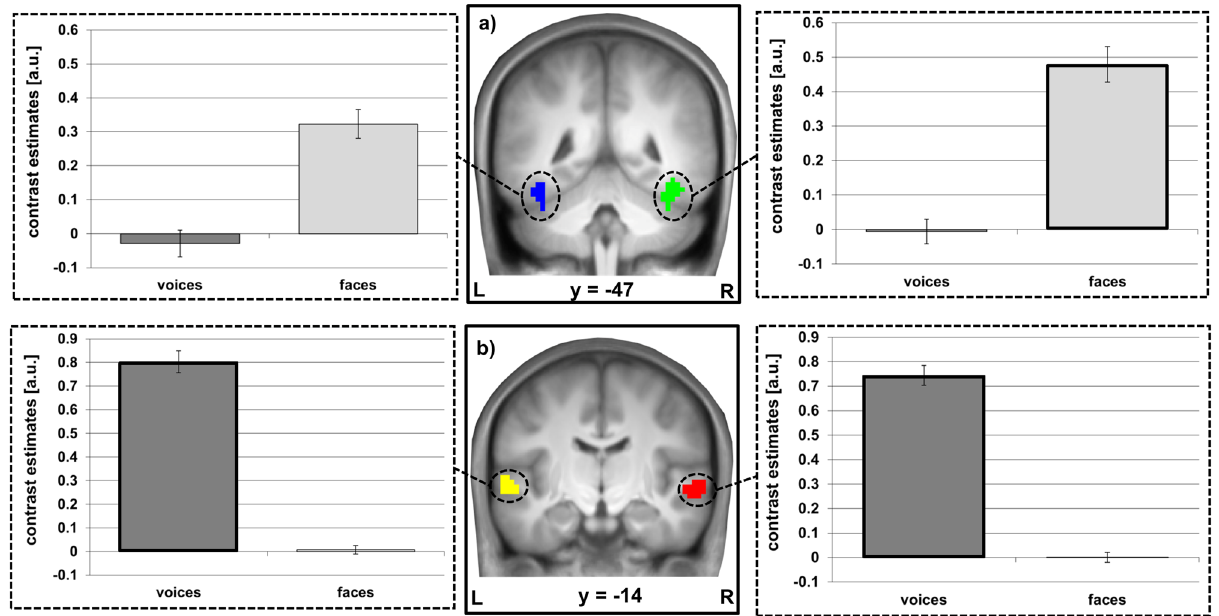
Figure 1. Face and voice processing areas. ( a ) The fusiform face area (rFFA in green, lFFA in blue), and ( b ) the temporal voice area (rTVA in red, lTVA in yellow), rendered onto the mean anatomical scan of the study population. The functional ROIs (i.e. FFA and TVA) were identified selecting the maximum activation in the fusiform gyrus and in the temporal lobe respectively, and defining the surrounding 100 most sensitive voxels as masks. Face-sensitivity is given as F > (H, O, S), voice-sensitivity as V > (A, E) for each subject. Individual voice- and face-preferential responses were assessed using minimum difference criteria (for voices V > max[A, E], for faces F > max[H, O, S]). The bars depict mean voice- and face-sensitivity of each region. Bold frames indicate that these regions respond also preferentially to the highlighted cues as compared to each of the experimental comparators (for details see “Materials and methods” section). Coordinates refer to MNI space. R right, L left. Error bars indicate the standard error of the mean. Additional material is available in the Supplement: Supplemental Fig. 1 depicts whole brain slices of the functional ROIs FFA and